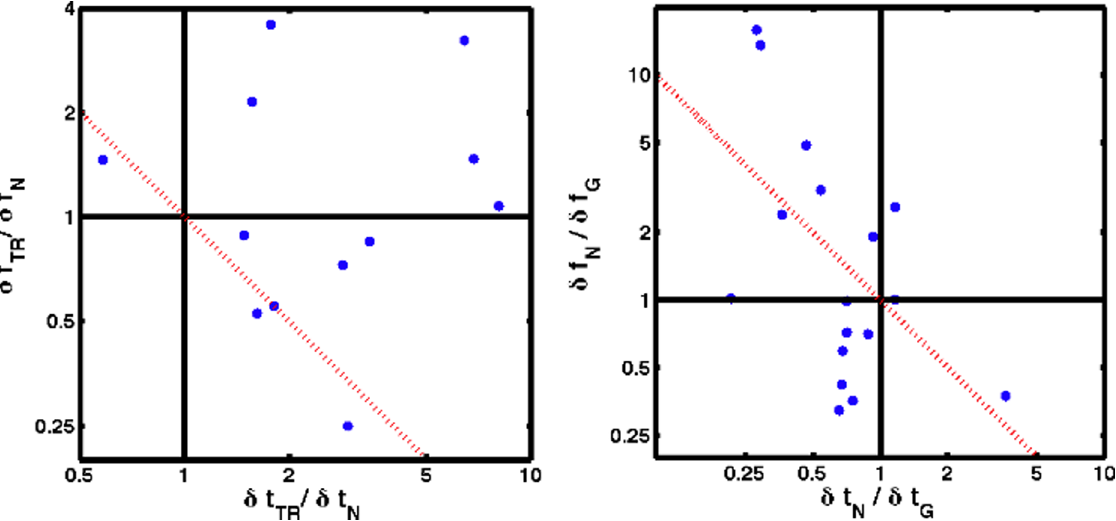
Figure 3. Difference in performance on different shaped notes. On the left is performance on the ‘‘time-reversed’’ pulse divided by performance on the ‘‘time-forward’’ notelike pulse. On the right is performance on the ‘‘notelike’’ pulse divided by performance on the gaussian pulse. The dotted red line indicates a perfect tradeoff in performance, i.e.